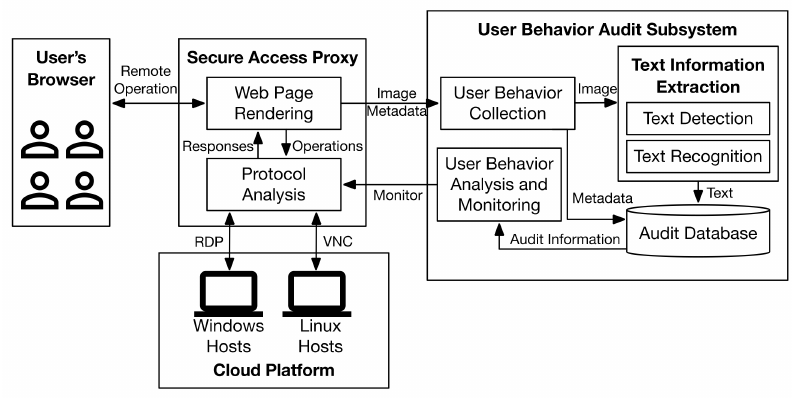
Figure 2. The structure of privileged user behavior audit